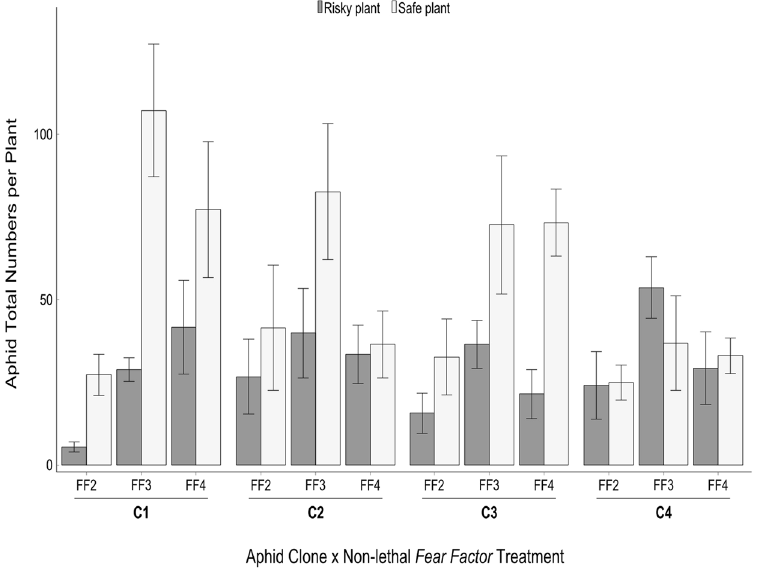
Figure 2. Aphid preference for safe vs . risky host plant after exposure to different levels of non-lethal predator- associated risk. Myzus persicae total numbers per plant (mean ± SE) across four clones (C1–C4) under different levels of non-lethal predator-associated cues ( Fear Factors: FF2–FF4). Aphid clones were exposed to visual- olfactory cues associated with the dead plant-tethered predator (FF2), shoot-sprayed cues (FF3) and soil- infused ones (FF4). The safe plant (non-treated with Fear Factor ) is depicted in blue while the risky plant is displayed in